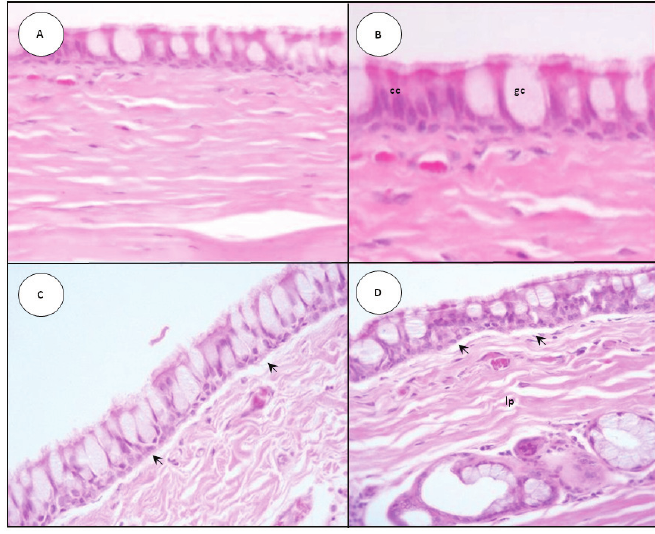
FIGuRE 2 - Control dog. Proximal trachea. Pseudostratified columnar epithelium with ciliated cells ( cc ) and goblet cells ( gc ) ( A and B ). Delicate basement membrane ( C and d , arrows). Lamina propria ( lp ) with collagen fibers and gland clusters ( d ). Light microscopy (H&E), x40.